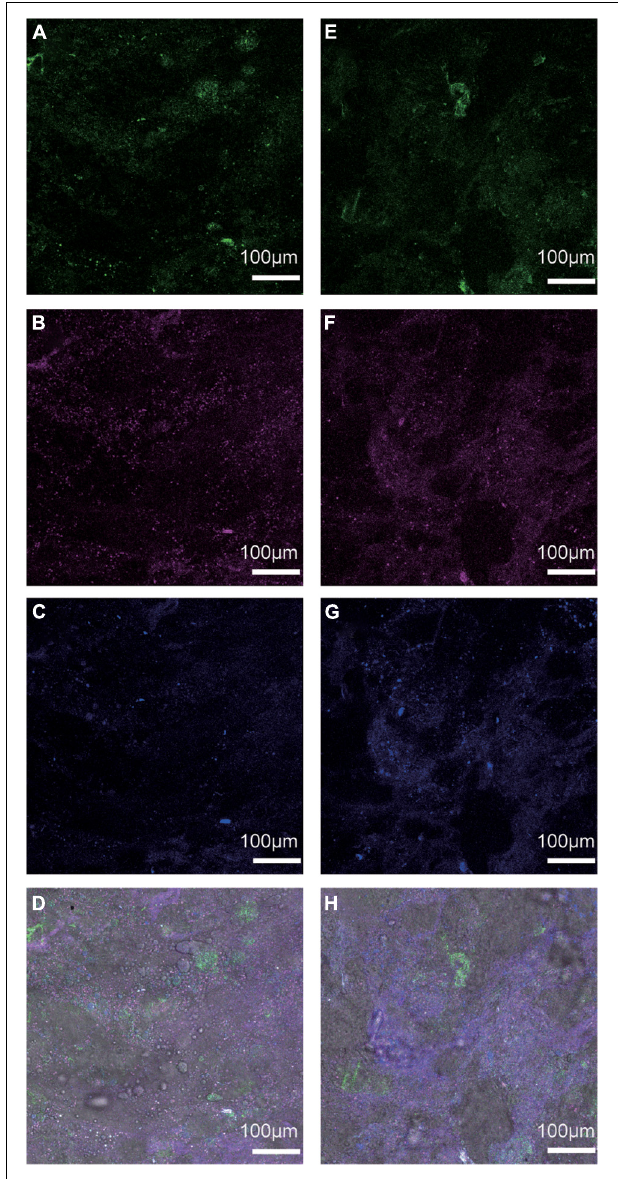
FIGURE 3 | FISH analysis of the localization of (A) Streptococcus (green), (B) Klebsiella (purple), (C) Enterococcus (blue), and (D) three bacteria in the larval midgut of ECB-M, and (E) Bacillus (green), (F) Enterobacter (purple), (G) Enterococcus (blue), and (H) three bacteria in the larval midgut of